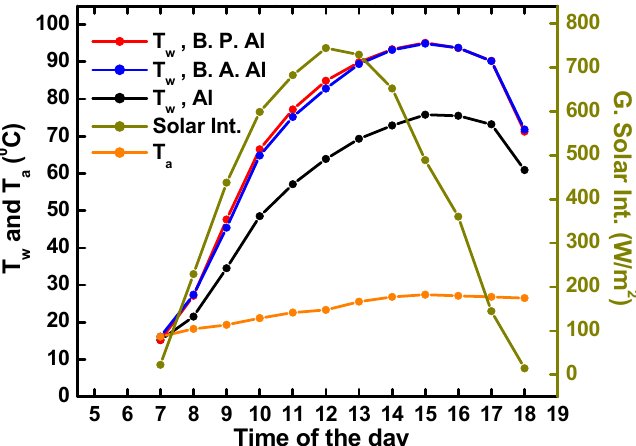
Figure 8. Water and ambient (T w , T a ) temperatures and global solar intensity vs. time of day for three cases as shown in the figure, Sunny Day, Date: 7 October 2021, Amman, Jordan.